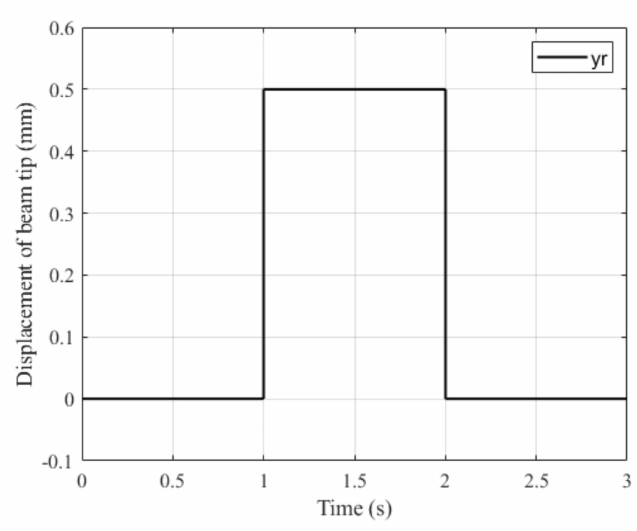
Figure 6. Reference displacement of a beam tip in all of simulation and laboratory experiments.